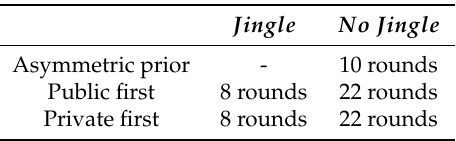
Table 2. Factorial design for every session (for both Q > q and Q ≤ q ). The row values are associated to the recency treatment (i.e., whether the private signal was displayed before or after the public). The column values are associated with the jingle treatment. The values within the matrix display the number of rounds for each